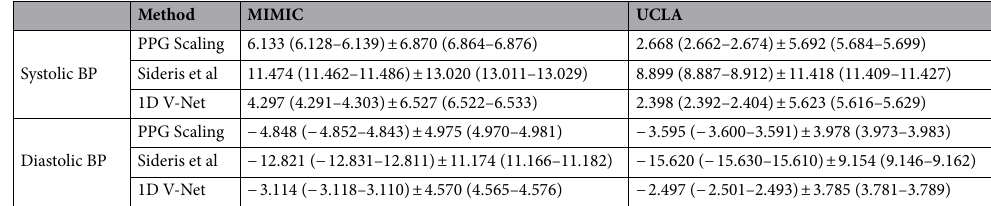
Table 4. Bland–Altman accuracy and precision (mean (95% CI) +/− SD (95% CI)) for each